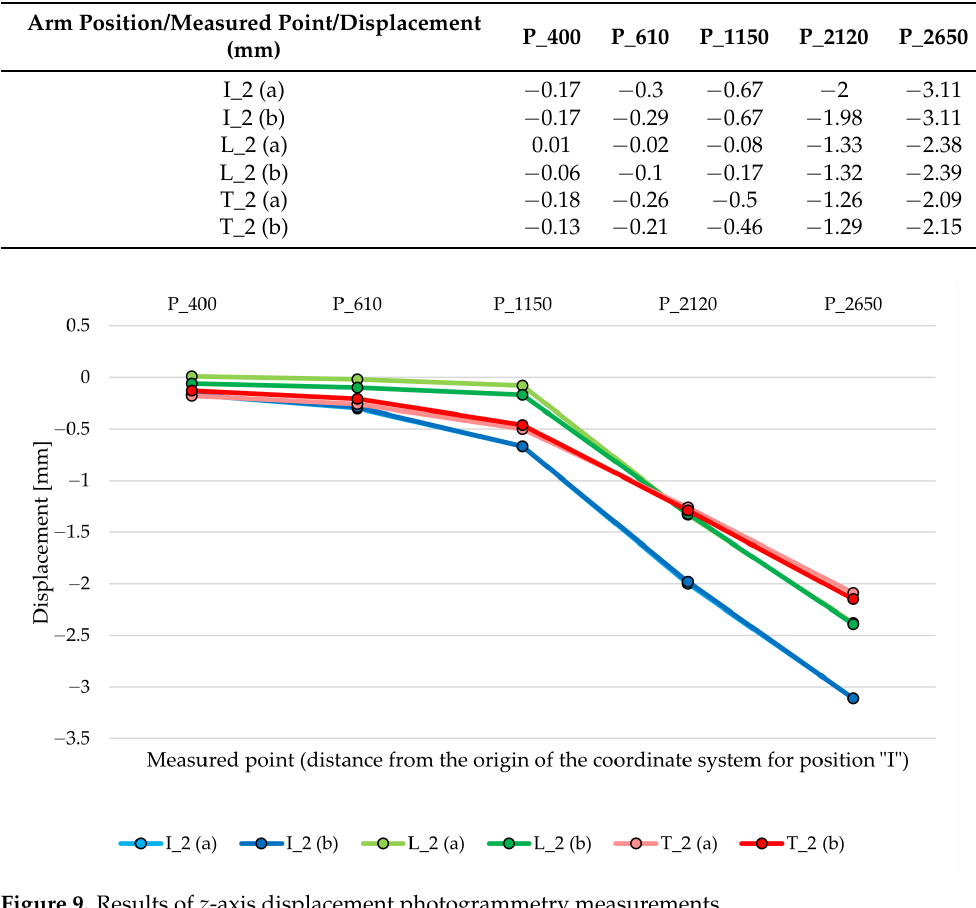
Figure 8. Displacements (deformations) of selected points in places measured by a deflection meter (State I_2 vs. I_1). Table 4. Results of z -axis displacement photogrammetry measurements.